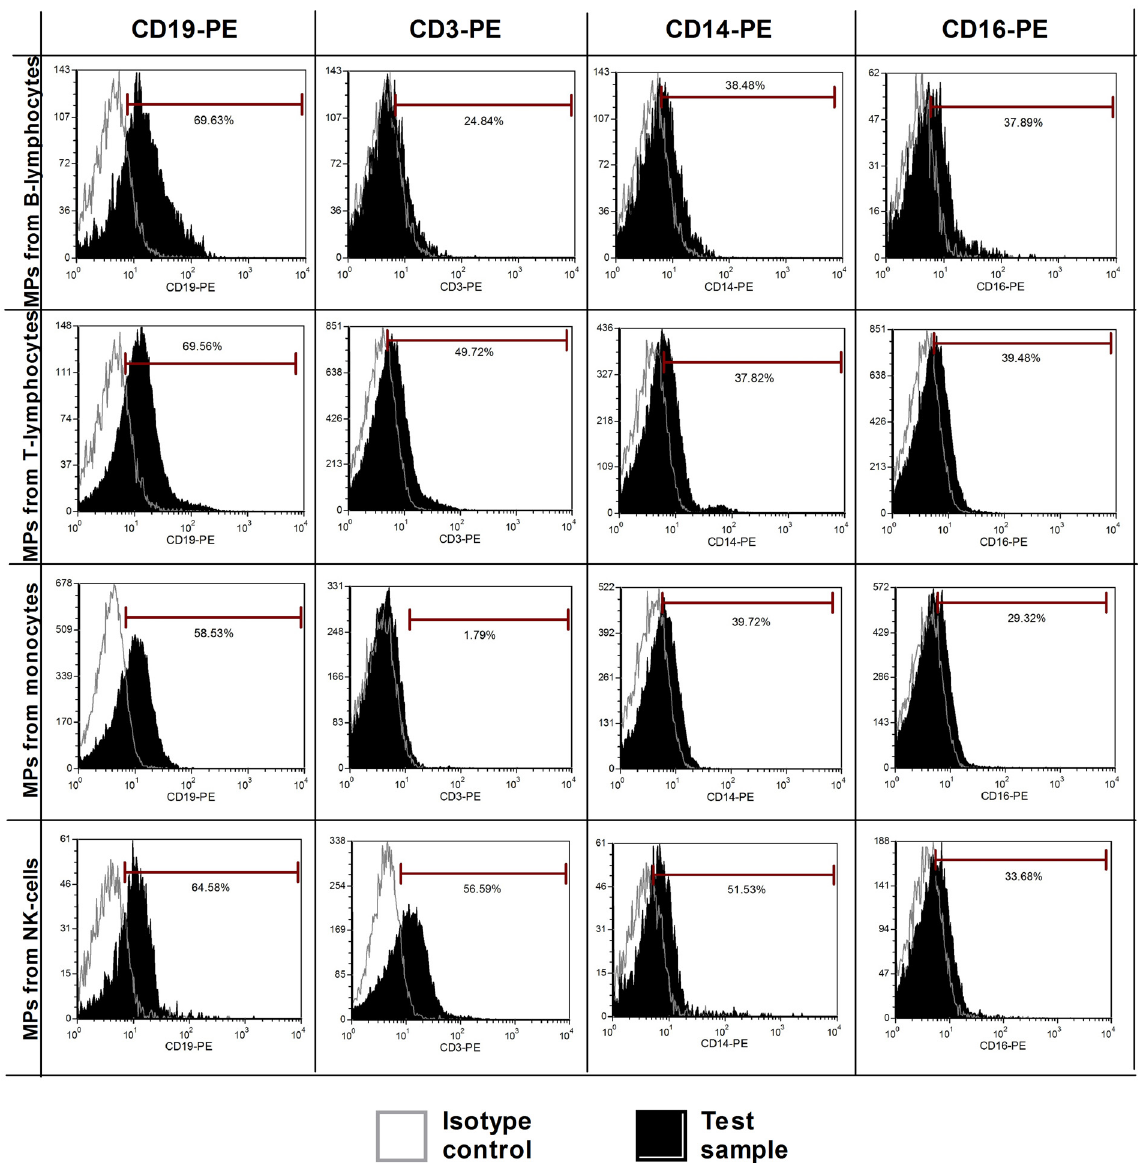
Fig 3. Cross-labeling MPs from different cell types: non-specific labeling. Double staining with annexin-V and specific markers was applied to four MP types (B-lymphocytes, T-lymphocytes, monocytes and NK-cells). Isotypes were used as negative controls (open line) and the tests are presented by filled histogram. Histograms of cell-derived MPs stained with CD19, CD3, CD14, and CD16 showed that non-specific labeling occurs for the majority of samples.